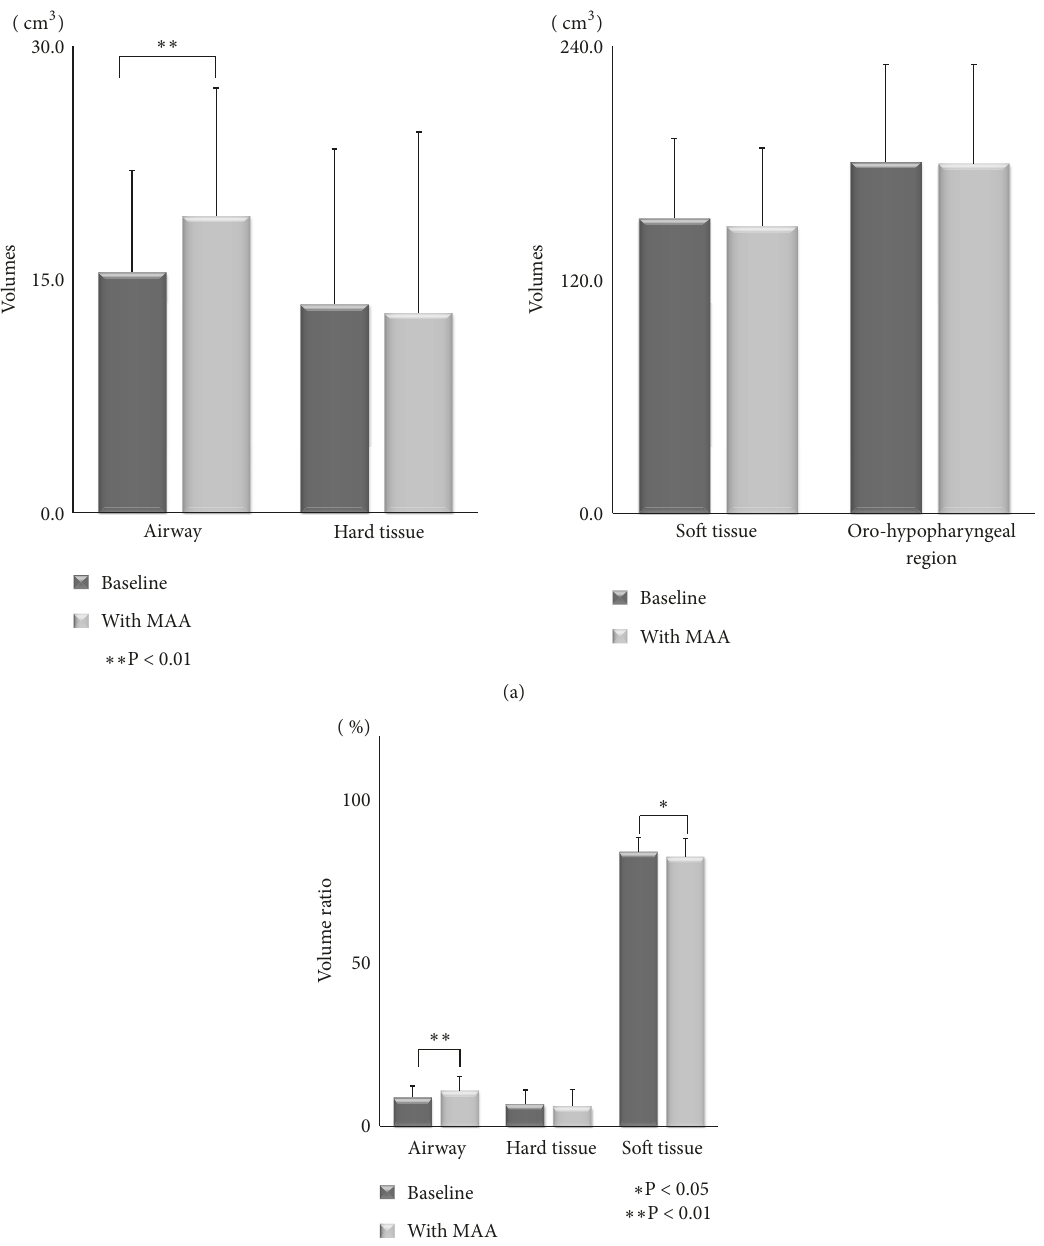
Figure 9: (a) Comparison of the airway, hard and soft tissue volumes, and oro-hypopharyngeal region between baseline and data with the mandibular advancement appliance (MAA). (b) Comparison of the ratios of the airway, and hard and soft tissue volumes in the oro- hypopharyngeal region between baseline and data with the mandibular advancement appliance (MAA).